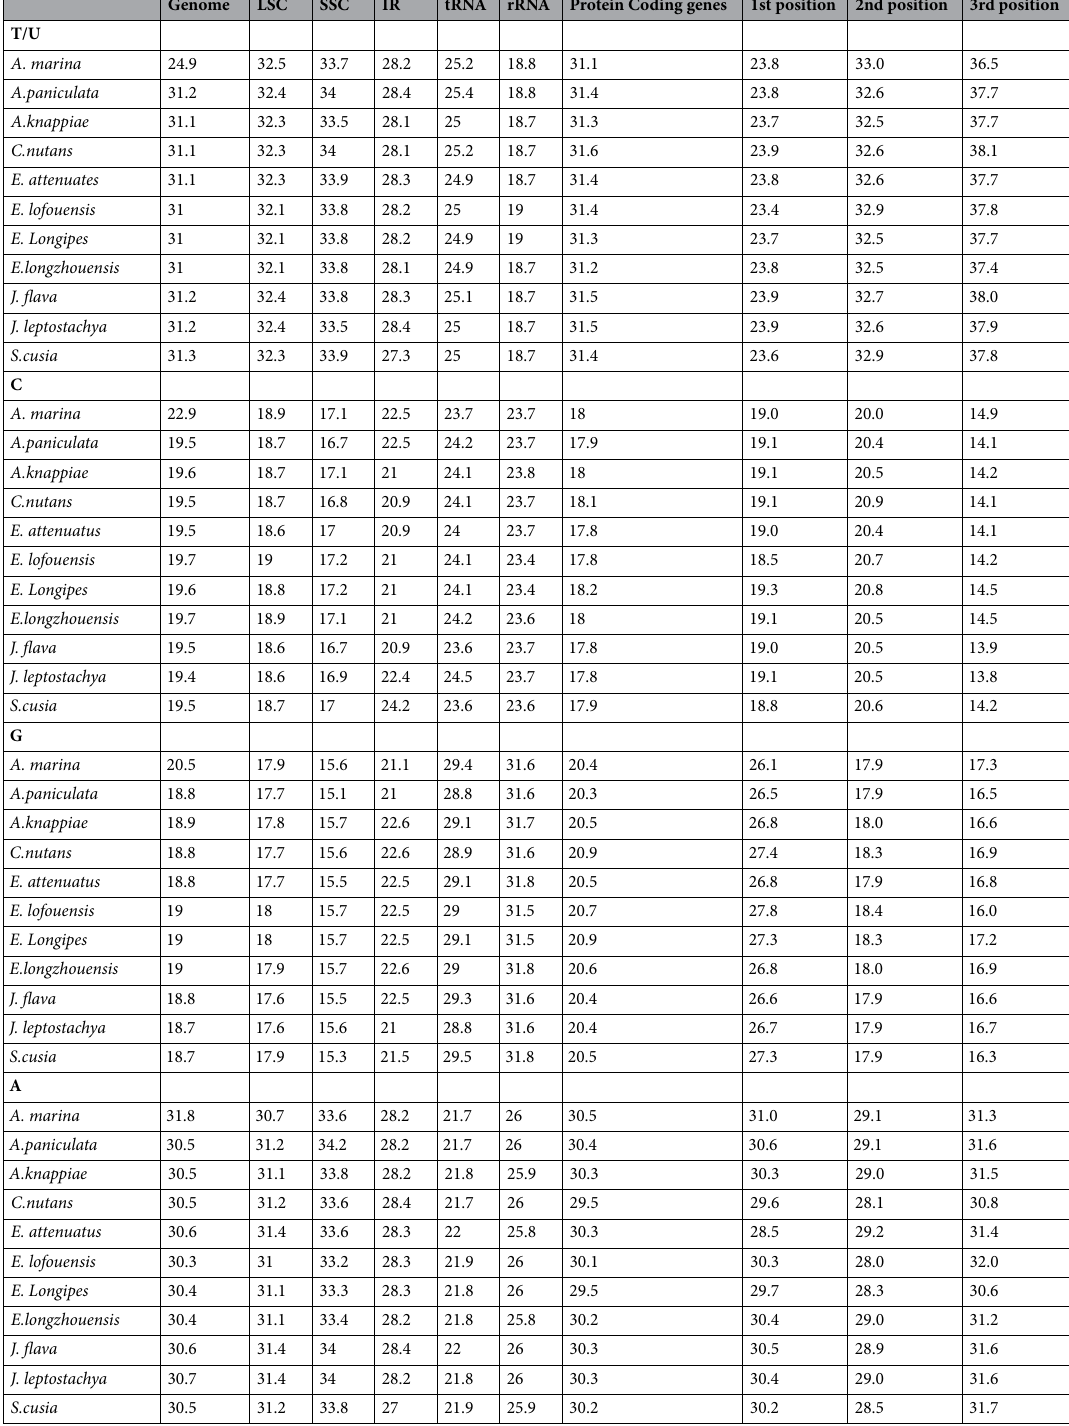
Table 3. Base composition of the A. marina and other related species cp